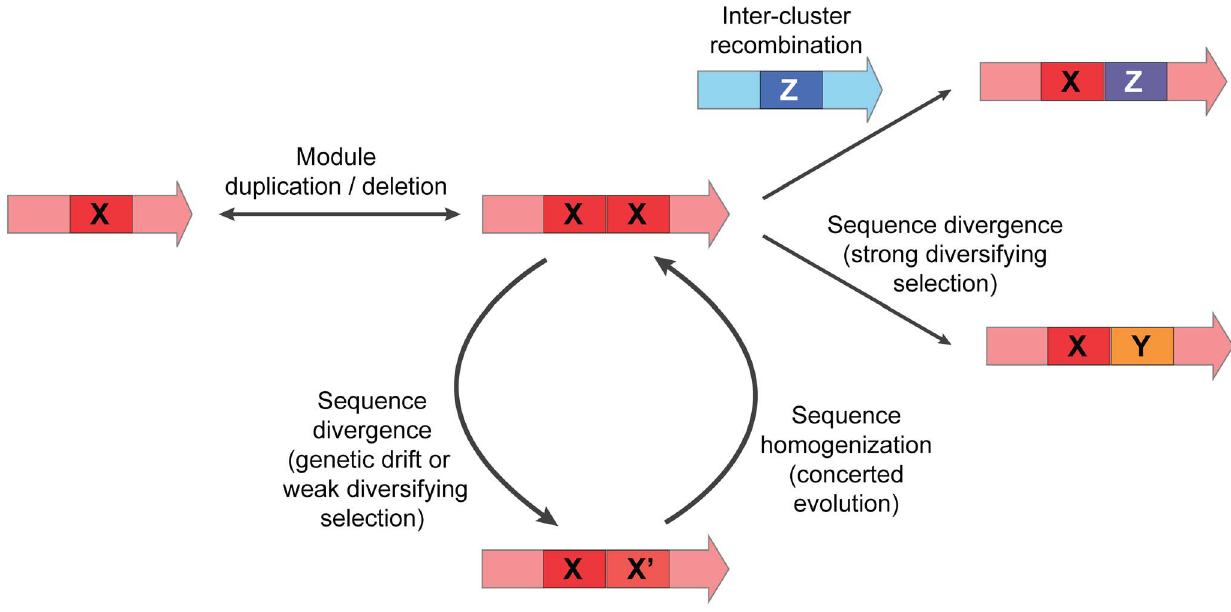
Figure 4. Qualitative model for the evolution of NRPS/PKS domains. After modules are duplicated, they may get ‘trapped’ in a cycle in which small sequence divergences are counterbalanced by internal recombinations that drive concerted evolution. Through strong diversifying selection (or sufficient drift), domains may break out of this cycle towards domain sequences that are protected from concerted evolution by functional divergence and subsequent stabilizing selection on the new function, or by reduced internal recombination rates due to larger sequence differences between the domains. The abovementioned sequence divergence may occur through cumulative mutation or through recombination with other gene clusters (or other modules within the same gene cluster).